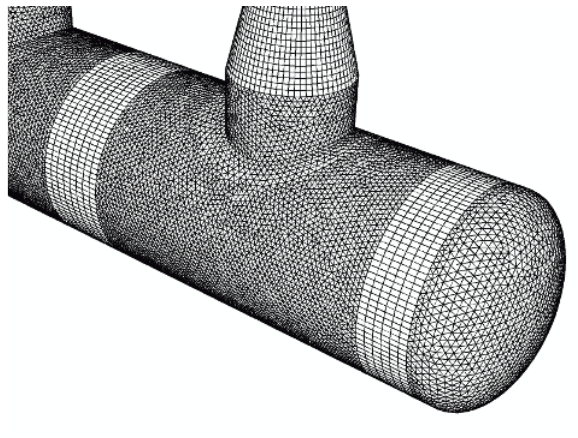
Figure 4: Surface mesh near the metering run starts